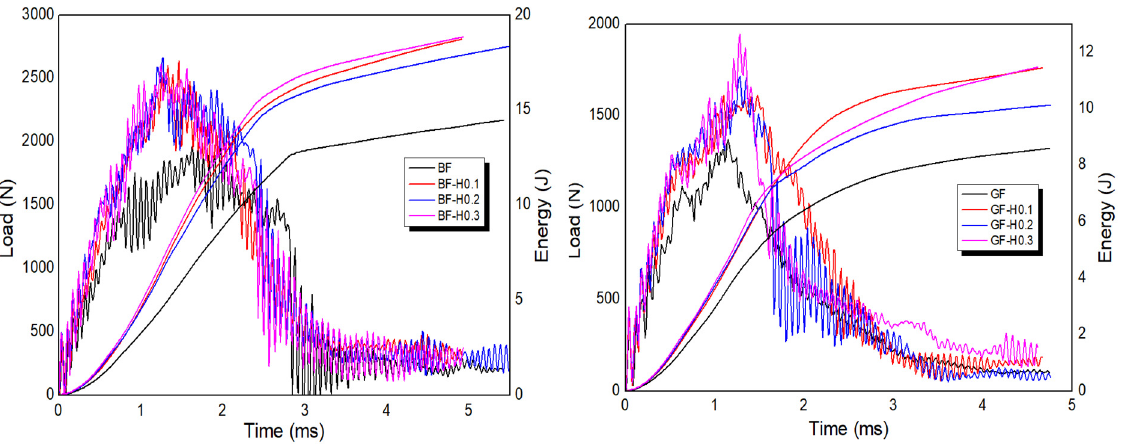
Figure 10. Typical load and energy versus time responses of BFRP and GFRP embedded with hybrid nanofiller.